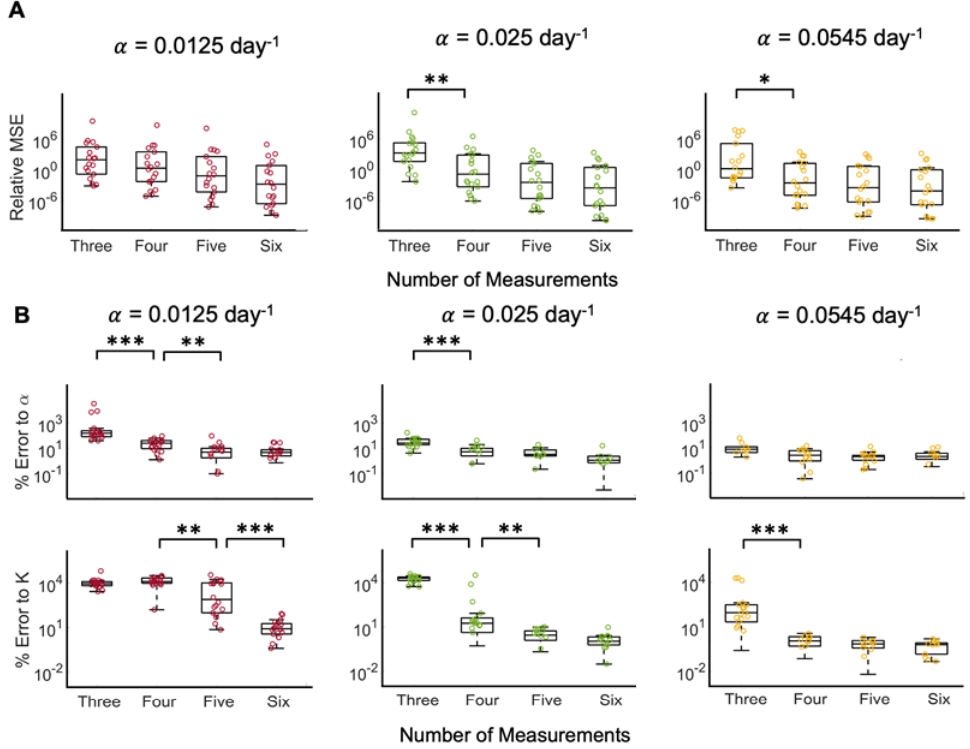
Figure 5. Error distributions of model fit to data with 5% noise. ( A ) Relative mean squared error (MSE) of model fit to ground truth data with different growth rates as a function of different measurements included in parameter estimation. ( B ) Percent error of model fit-derived logistic growth parameters (growth rate, 𝛼 , and carrying capacity, K ) to ground truth parameters as a function of different measurements included in parameter estimation. Statistical significance is denoted by asterisks (* for p < 0.01, ** for p < 0.005, and *** for p < 0.001).